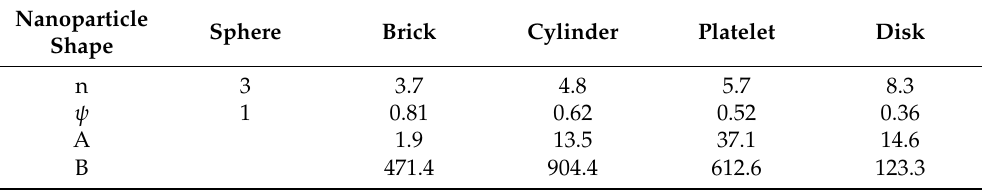
Table 4. Sphericity, empirical shape factor, and A, B for non-spherical nanoparticles [18,23–25].